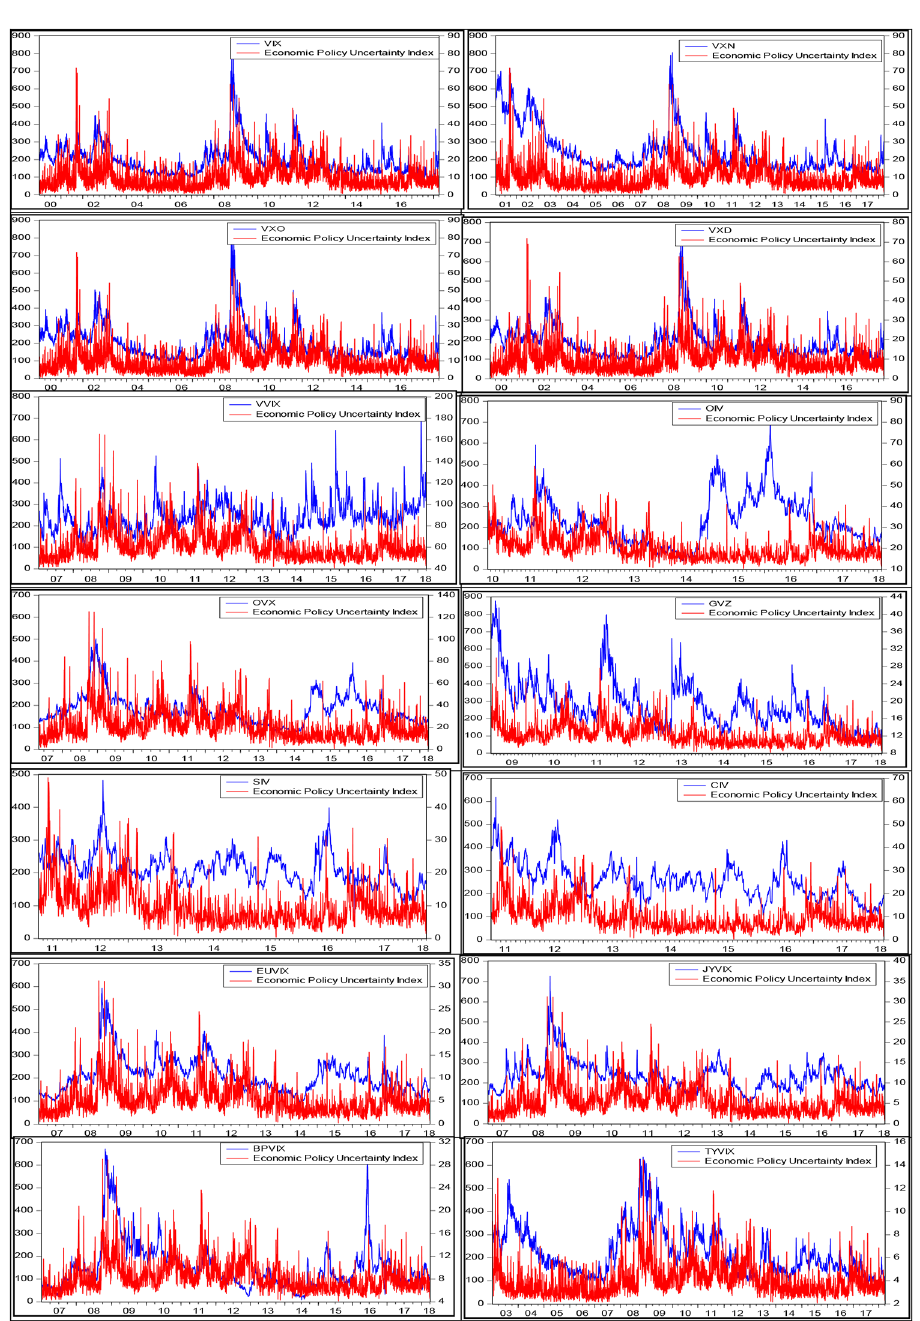
Figure 1. Time series plot of Implied volatility index across assets and Policy Uncertainty in the